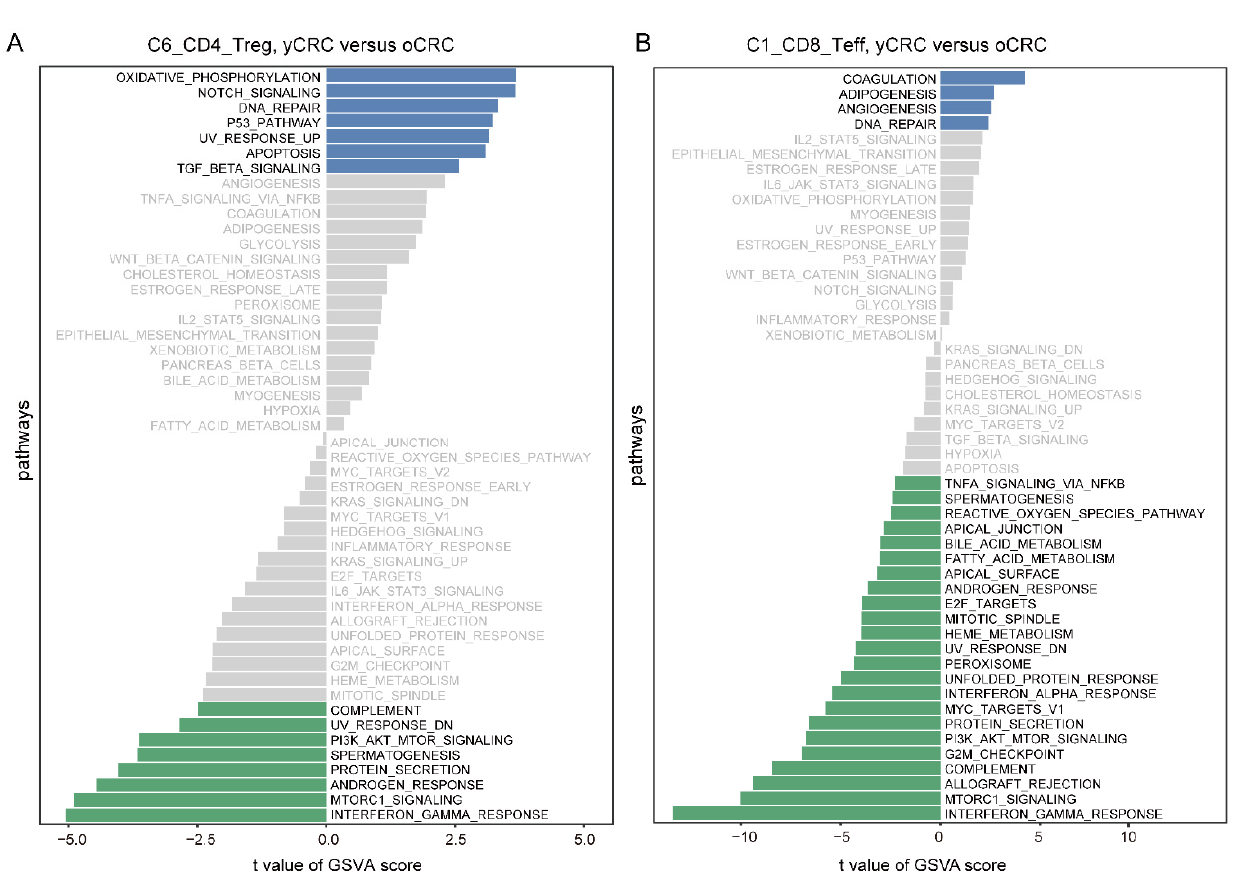
expression of T cell functional phenotype genes in different groups. ( F ) Pseudotime reconstruction and developmental trajectory of CD4+T cells inferred by Monocle 3. Cells are colored by pseudotime (left). UMAP visualization of CD4+T cells (right). ( G ) Differential genes expression dynamics resolved along pseudotime. ( H ) Volcano plot showing differentially expressed genes between C6_CD4_Treg cells of yCRC and oCRC. yCRC versus oCRC, down (up) represents differential genes downregulated (upregulated) in yCRC C6_CD4_Treg.